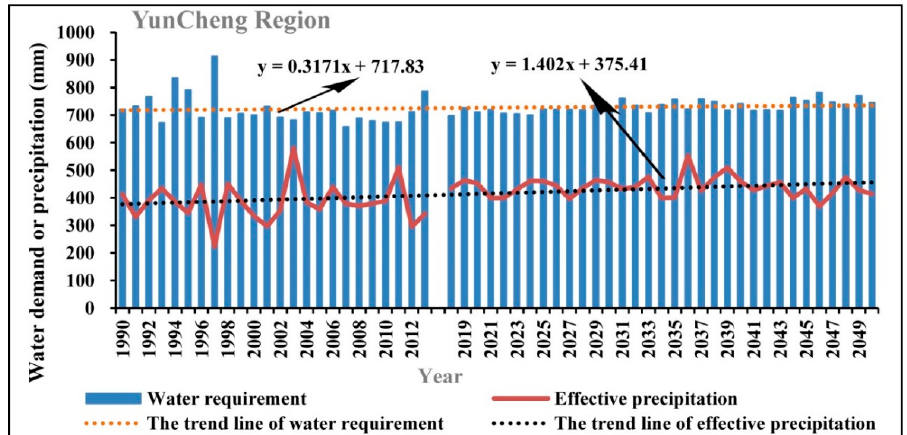
Figure 10. The changing trend of the water demand of apple trees and the effective precipitation in Yuncheng Region in the periods of 1990–2013 and 2019–2050.